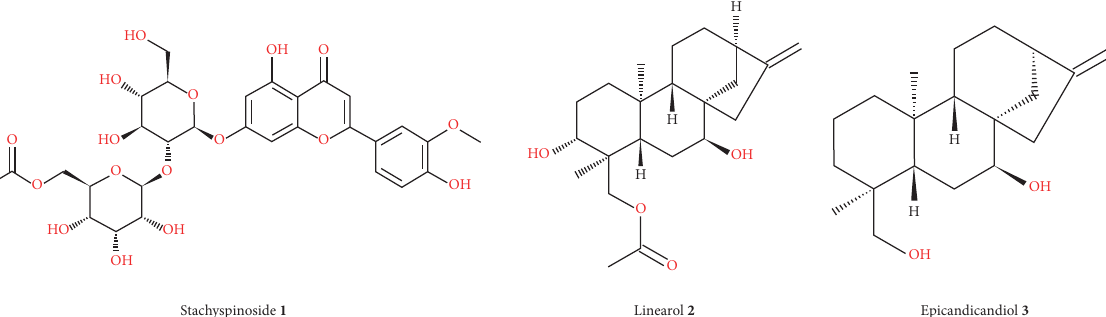
Figure 1: Chemical structures of the isolated compounds in S. congesta . (a) Stachyspinoside 1 . (b) Linerol 2 . (c) Epicandicandiol 3